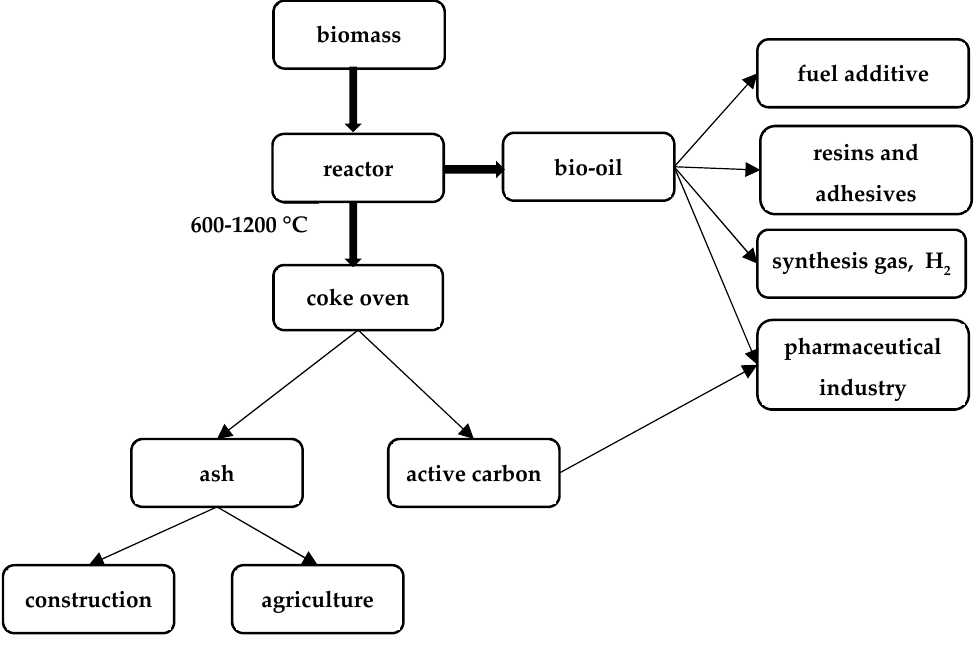
Figure 3. Scheme of pyrolysis.